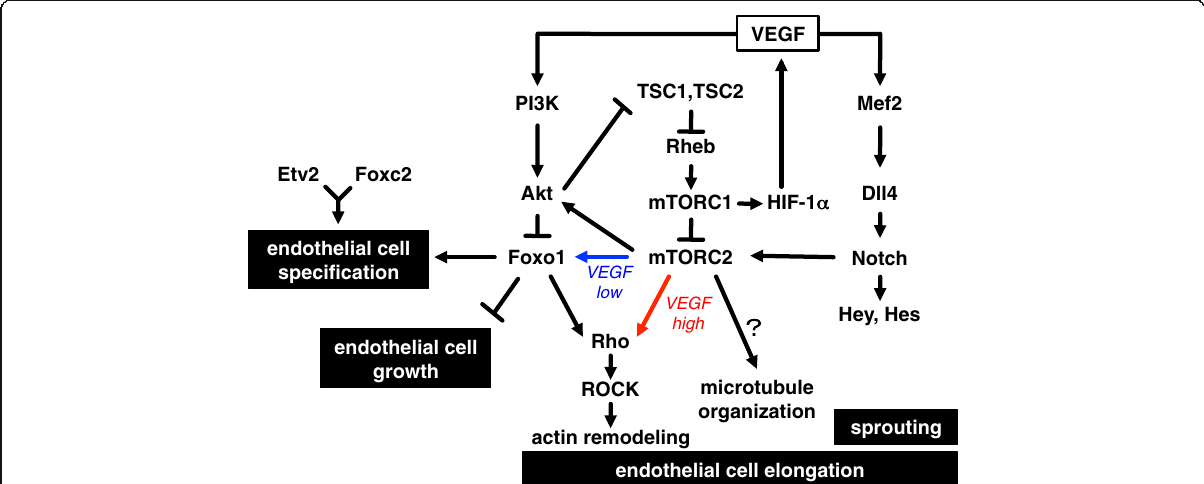
Fig. 2 Schematic model of transcription factor and signaling molecule interactions in endothelial cell functions. VEGF regulates endothelial cell functions through interaction and association with PI3K-Akt, mTOR, and Notch signaling. Foxo1-dependent (blue) and Foxo1-independent (red) pathways for endothelial cell elongation are shown. Pathway depends on environmental levels of